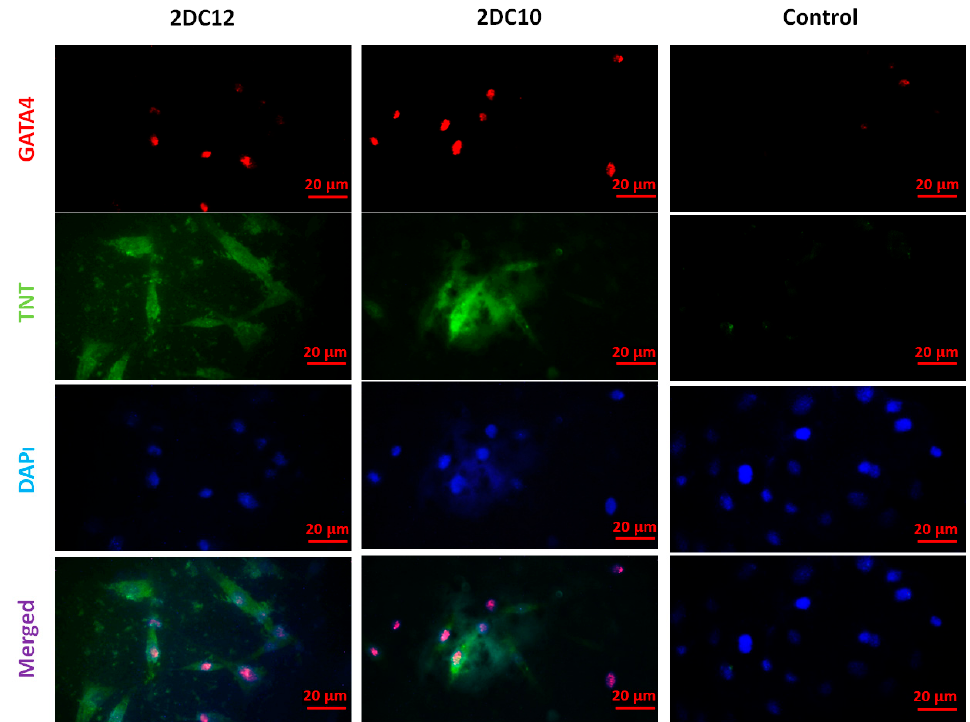
Figure 8. Immunofluorescent microscopy images of the cardiac assay of the rMSC after two weeks of culture on various hydrogels. The rMSCs express the contractile protein, cardiac troponin T (TNT) (green), as well as the cardiac-specific transcription factor, GATA4 (red). Cell nuclei were stained by DAPI (blue). The scale bar is 20 μ m.